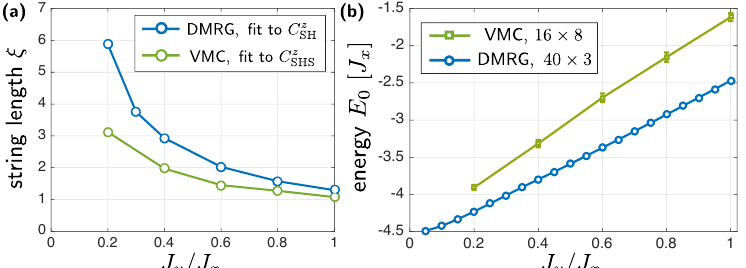
Figure 5: Dimensional crossover. We change from a 1D to a mixD situation by / J tuning J at t = 3 J . (a) The string length ξ , extracted by fits of spin-hole cor- y x x → 0. This indicates a deconfinement of the relators C z , sharply increases when J y SH spinon-holon pair in this limit. (b) We compare the ground state energy E of a single 0 hole from DMRG in a 40 × 3 system to the variational energy of the trial wavefunction = ( π/ 2, π/ 2 ) , Φ = 0.5 π using VMC in Eq. (4) in a 16 × 8 system, evaluated at k MP methods, see Methods for more